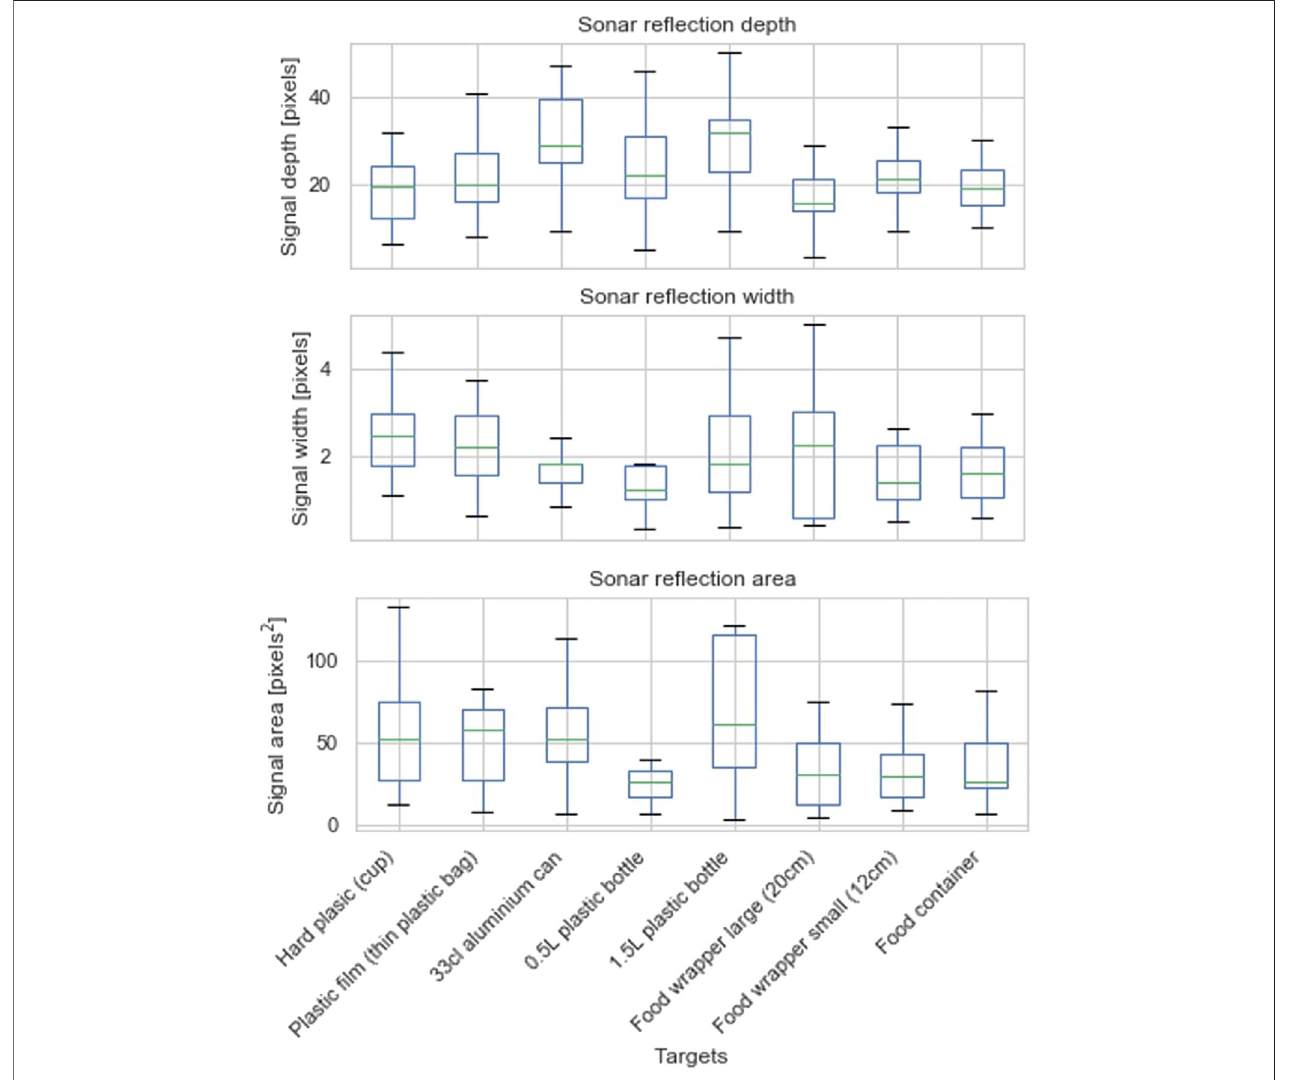
FIGURE 7 | The total data of the sonar re fl ection depth, width and area, for the different debris items (targets). The green line presents the median, the box is bounded by the fi rst (Q1) and third (Q3) quartile, the whiskers are bounded by the upper and lower data point within the inter-quartile-range (IQR (cid:1) Q3 – Q1).